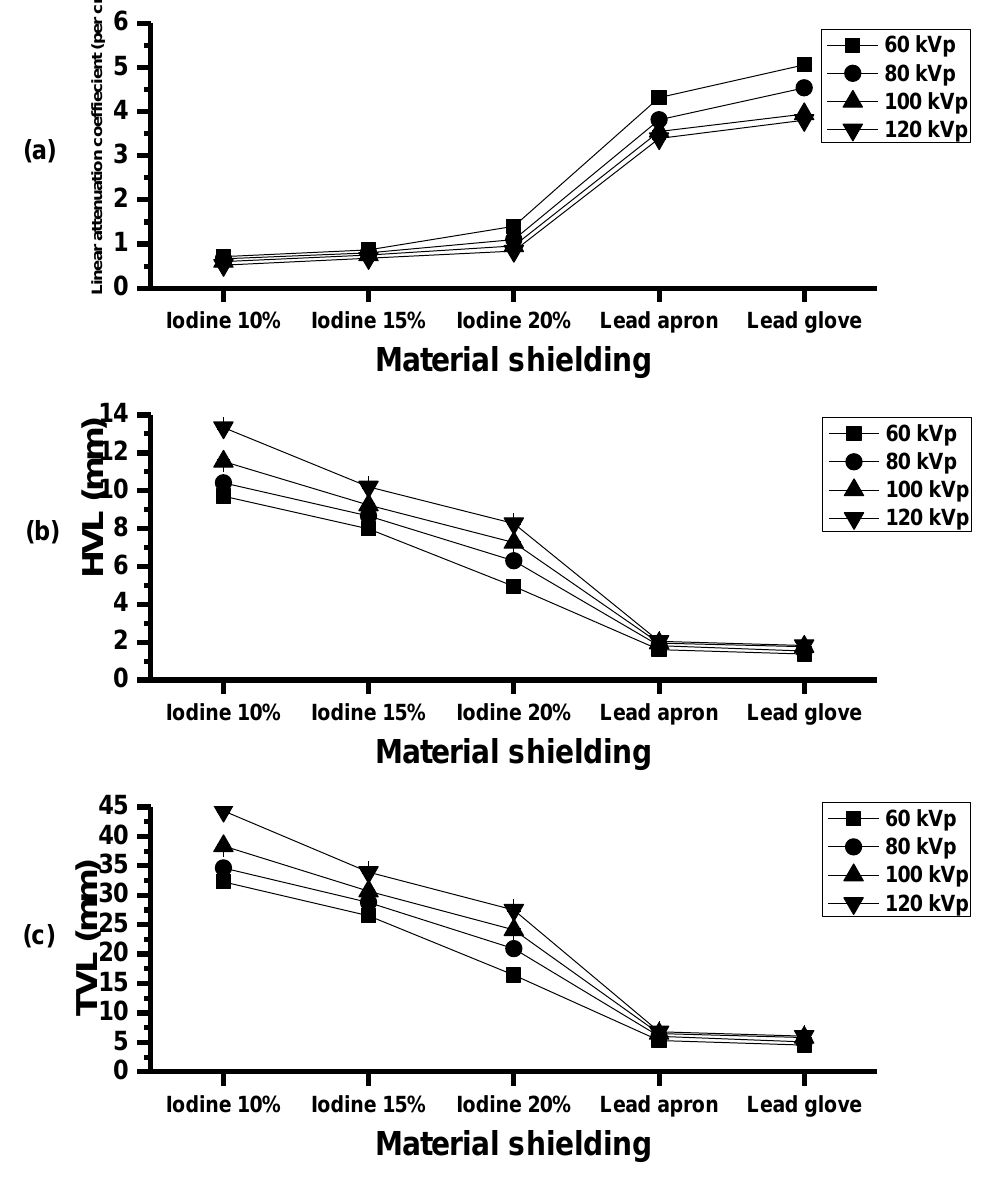
Figure 6. ( a ) Linear attenuation coefficient of the epoxy shielding material. ( b ) Half-value layer and ( c ) tenth-value layer of epoxy shielding material.